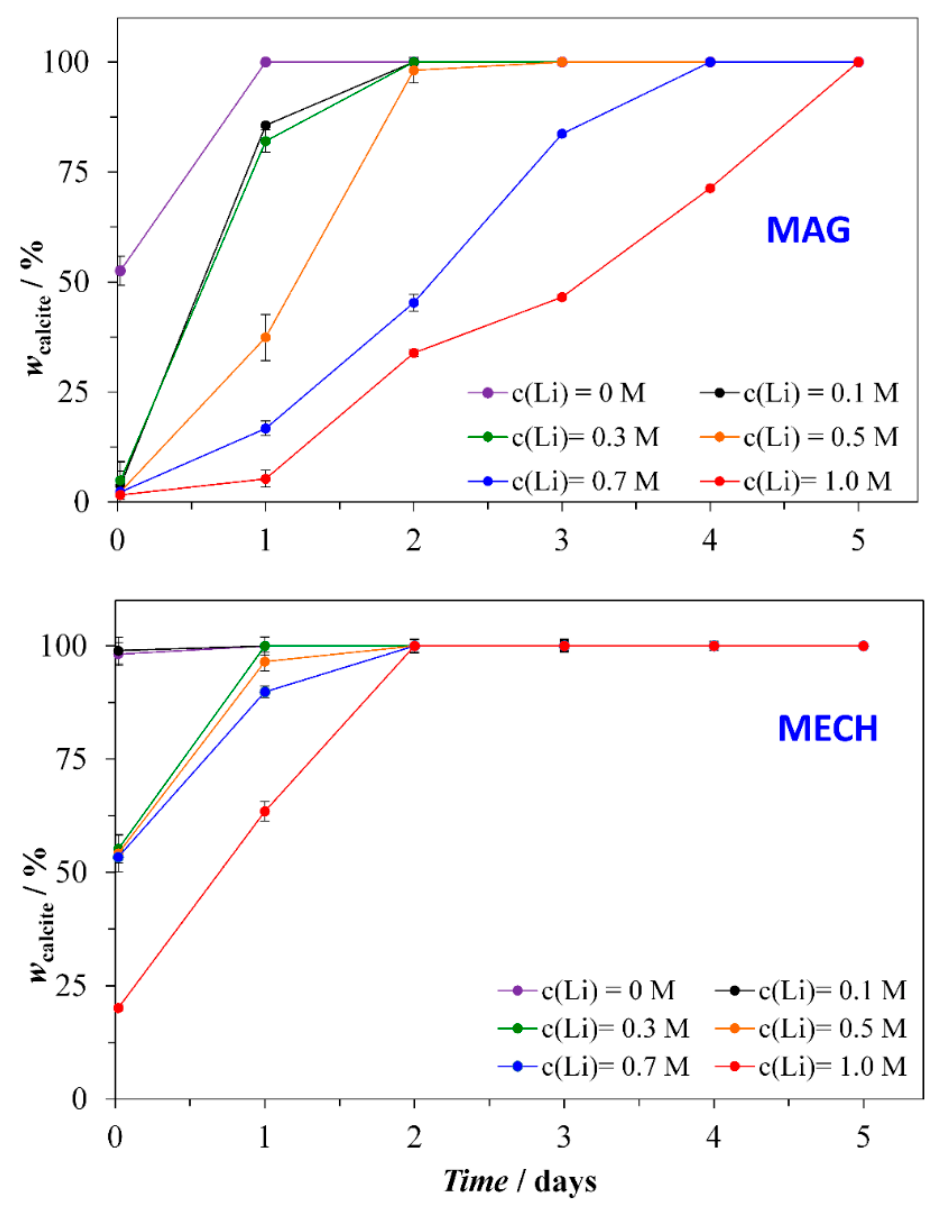
Figure 1. Amount of calcite in the precipitate during the transformation process in the systems, c i (CaCl 2 ) = c i (NaHCO 3 ) = 0.1 mol dm − 3 , different mode of stirring and initial concentration of lithium ions. The initial concentrations of Li + are indicated: M correspond to mol dm − 3 , MAG—magnetic stirring, MECH—mechanical stirring. The quantification of the relative amounts of calcite and vaterite was determined by X-ray diffraction analysis.